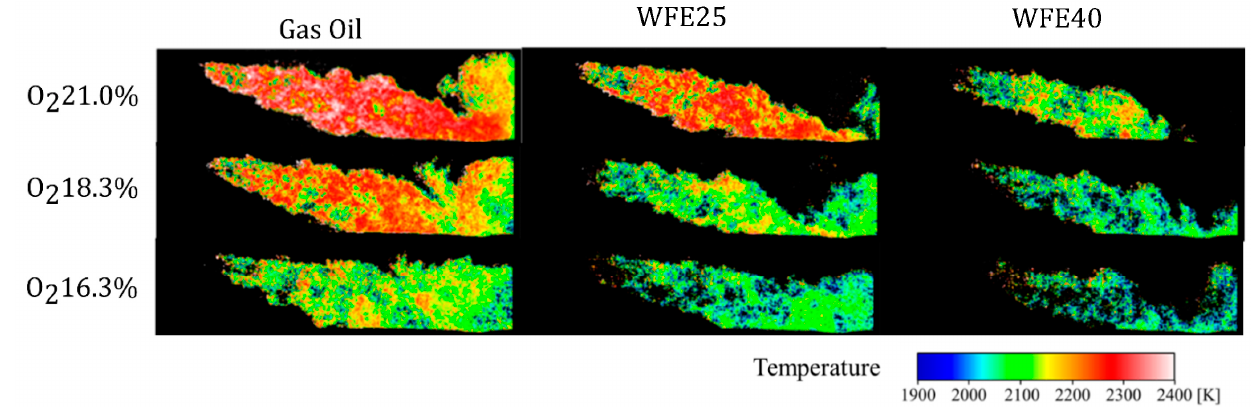
Figure 13. Flame temperature distributions calculated by the two-color method at 10 °CA ATDC.